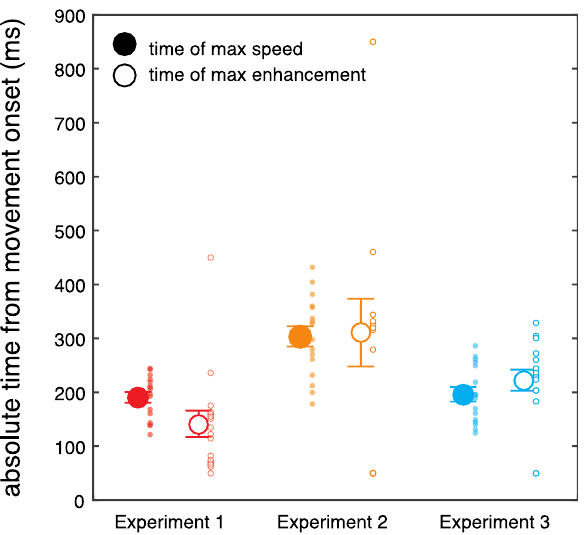
Figure 5. Time of absolute maximal speed and of maximal sensory enhancement for each experiment. The moment of maximal somatosensory enhancement is in close temporal proximity with the moment of maximal speed. This is evident in all three experiments. Large symbols represent averages with error bars indicating the standard error of the participants’ mean and small symbols represent individual